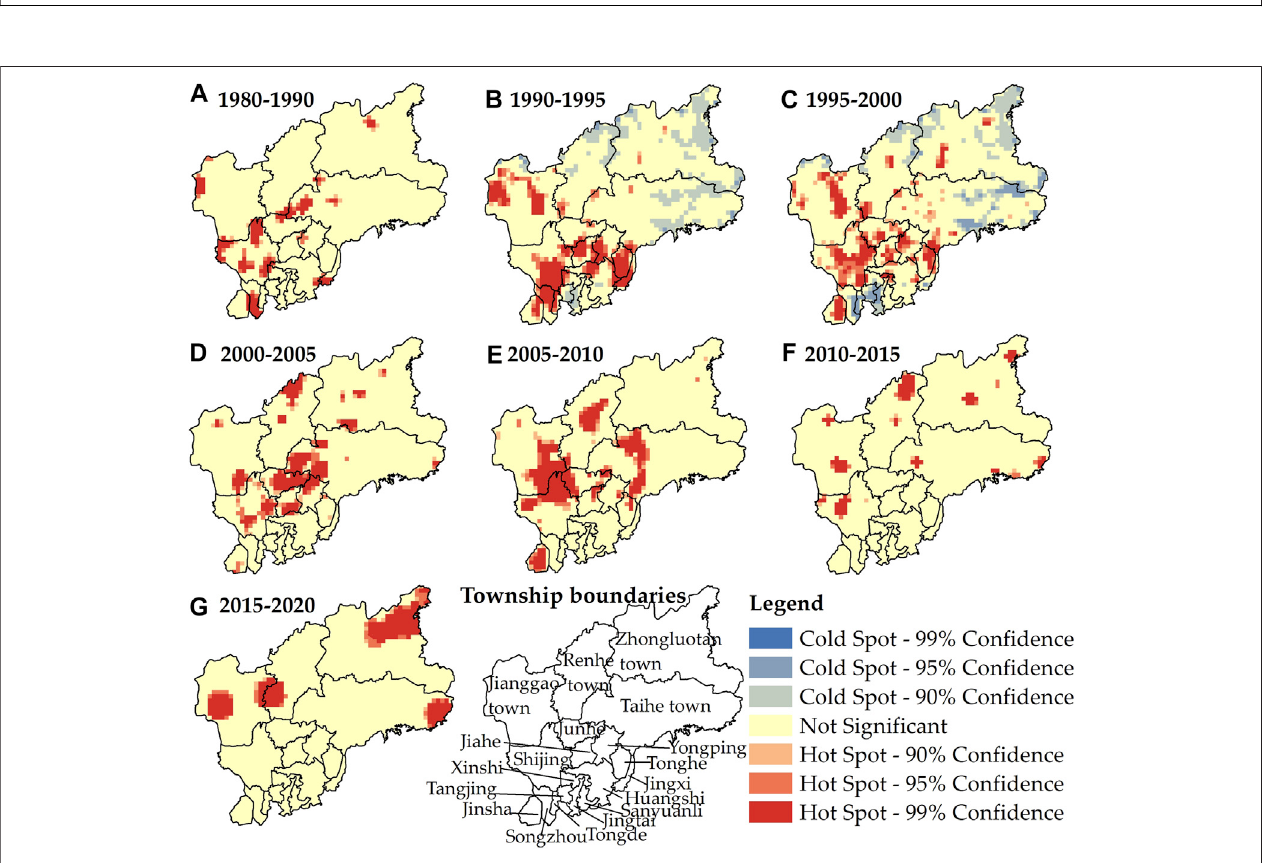
FIGURE 7 | Analysis on hot spots of land activities in different periods from 1980 to 2020 (A – G) .